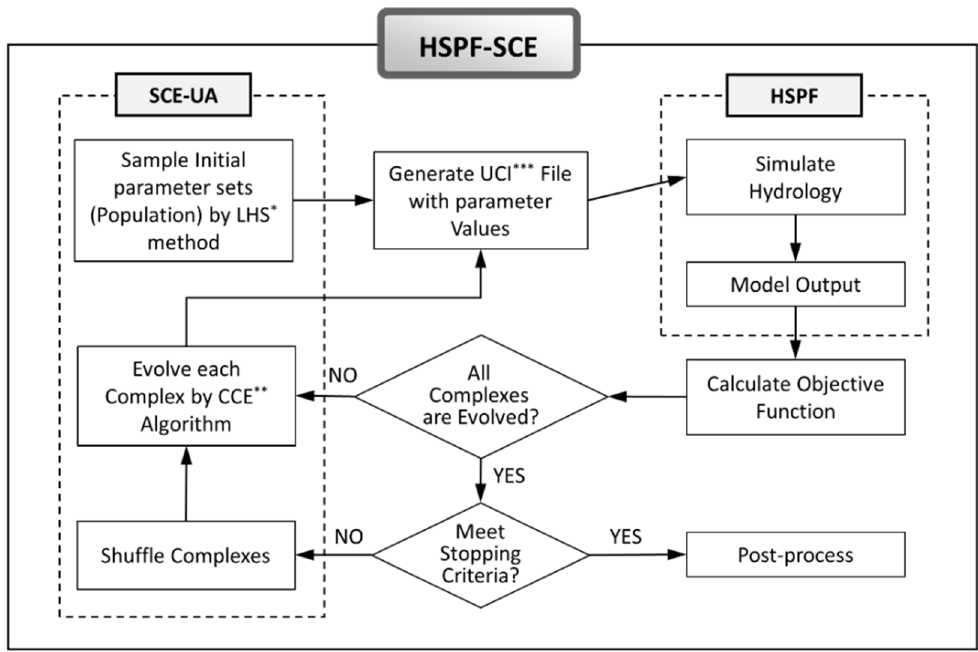
Figure 1. Flow chart for HSPF-SCE. Notes: LHS*: Latin Hypercube Sampling; CCE**: Competitive Complex Evolution; UCI***: User Control